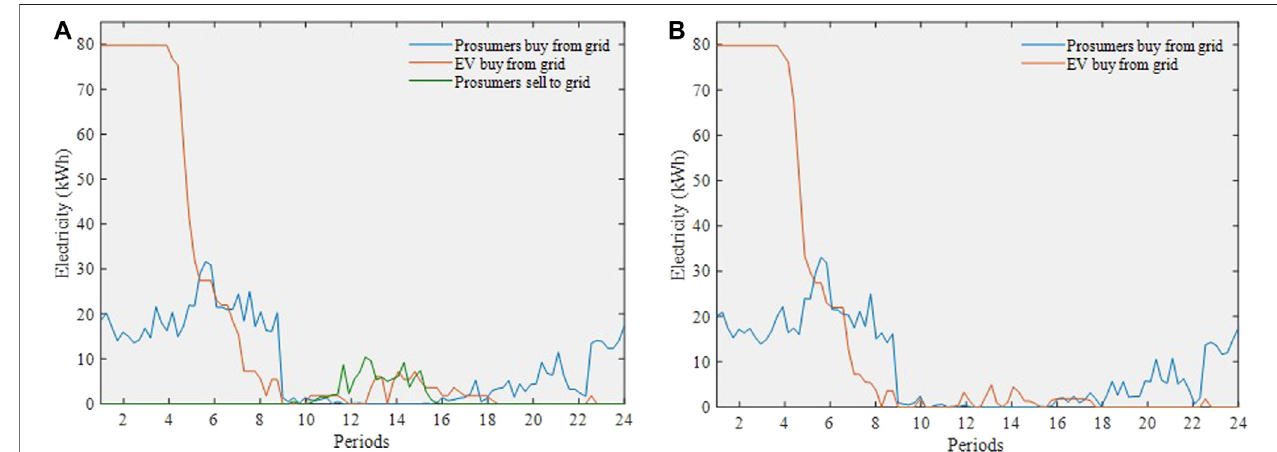
FIGURE 8 | Transactions on grid for decentralized (A) scenario A and (B) scenario B.